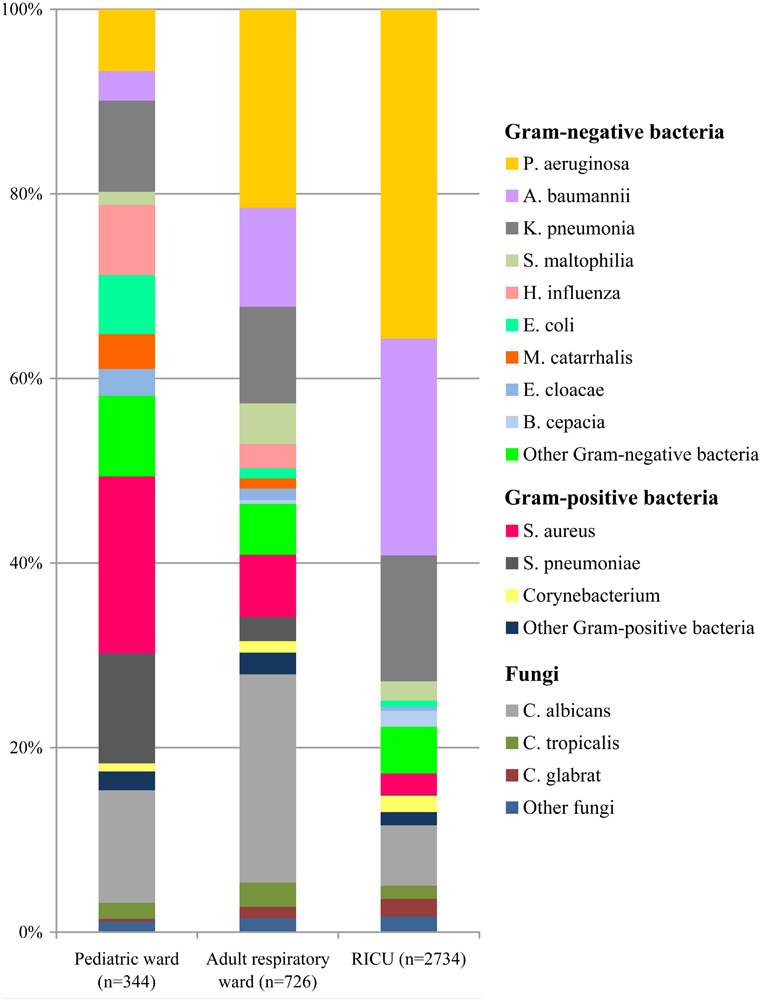
Distribution of microorganisms in positive respiratory tract cultures of lower respiratory tract infection patients from the pediatric ward, adult respiratory ward, and respiratory intensive care unit (RICU). Gram-negative bacteria remained the major pathogens among the respiratory tract cultures. P. aeruginosa, Pseudomonas aeruginosa; A. baumannii, Acinetobacter baumannii; K. pneumonia, Klebsiella pneumonia; S. maltophilia, Stenotrophomonas maltophilia; H. influenza, Haemophilus influenza; E. coli, Escherichia coli; M. catarrhalis, Moraxella catarrhalis; E. cloacae, Enterobacter cloacae; B. cepacia, Burkholderia cepacia; S. aureus, Staphylococcus aureus; S. pneumonia, Streptococcus pneumonia; C. albicans, Candida albicans; C. tropicalis, Candida tropicalis; C. glabrata, Candida glabrata.